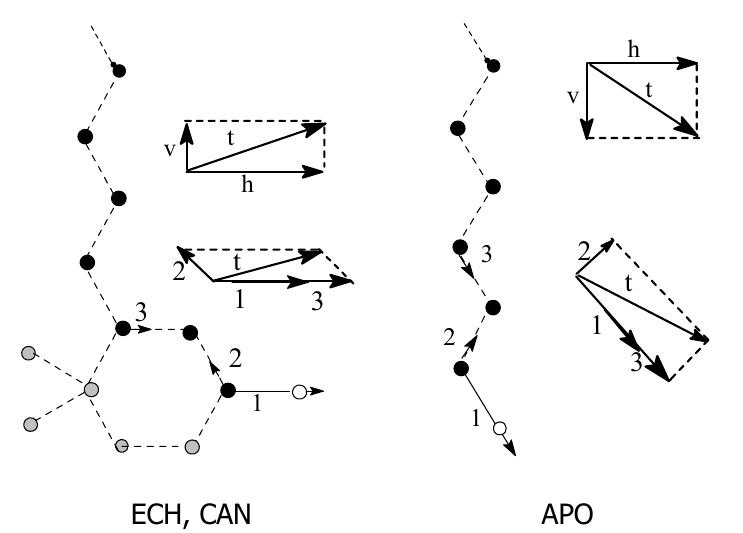
Fig. 2 Composition of the dipole moments of the first 3 bonds, and the